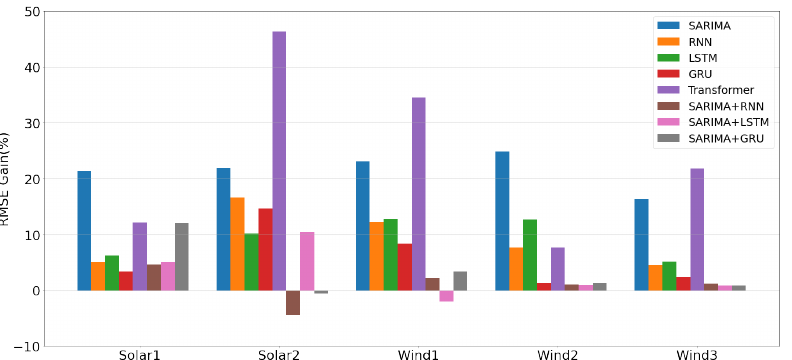
Figure 3. The percentage difference (Equation (11)) between H-Transformer and literature methods in terms of RMSE.